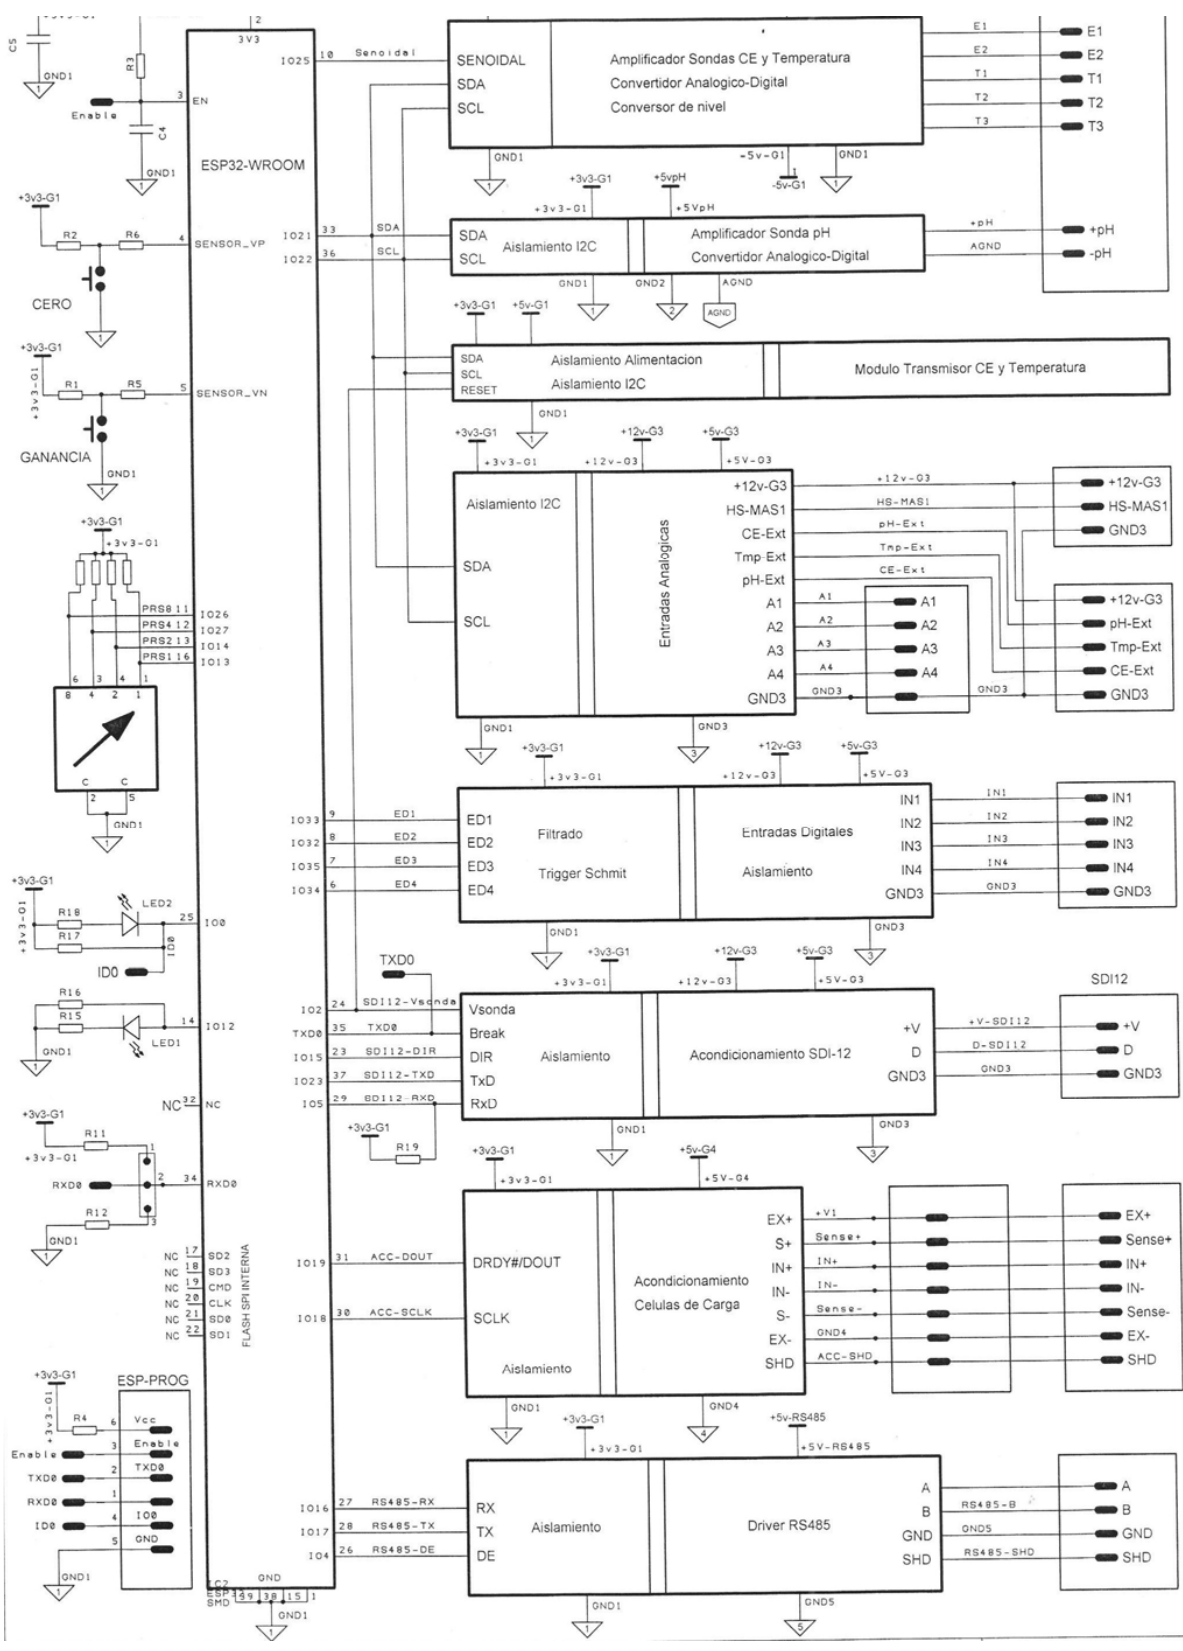
Figure A2. Data Acquisition Card (SDB) Block Diagram.